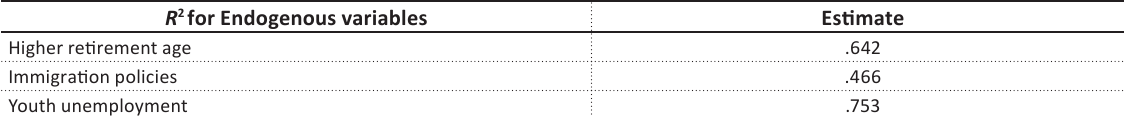
Table 2. Squared multiple correlations ( R 2 )